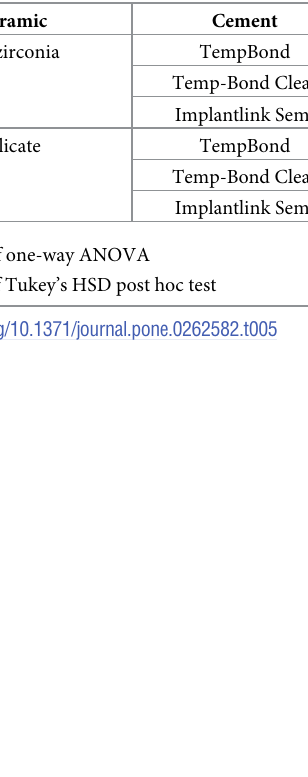
Table 5. Mean and standard deviation and pairwise comparison of retentive strength (N).